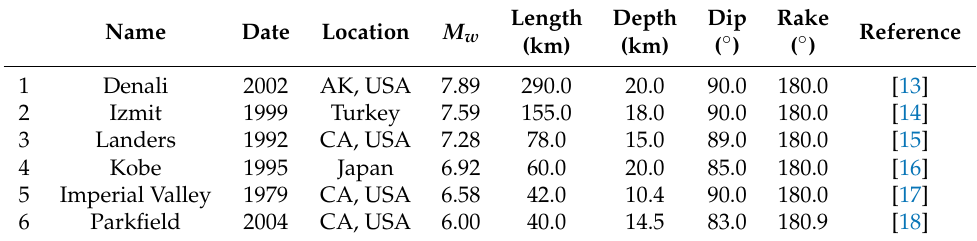
Table 1. List of past earthquakes with fault geometry and rupture mechanisms closely matching earthquakes on the San Andreas fault whose kinematic finite source inversions are used in this study. The salient source parameters are listed as